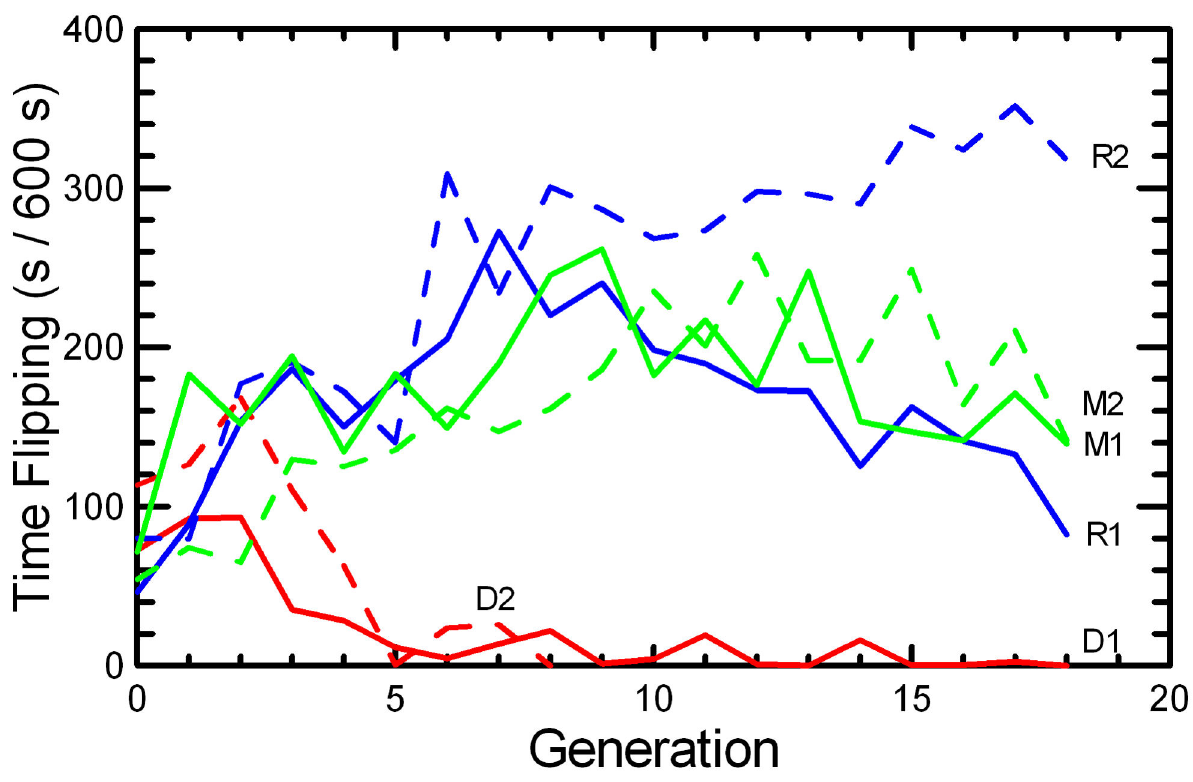
Figure 3. Mean time spent in stereotypic Flipping behavior. The mean number of seconds per 600 s observation period that mice spent in Flipping behavior is given for the two replicates of RAN (blue), MK (green), and DOC (red) experimental populations.